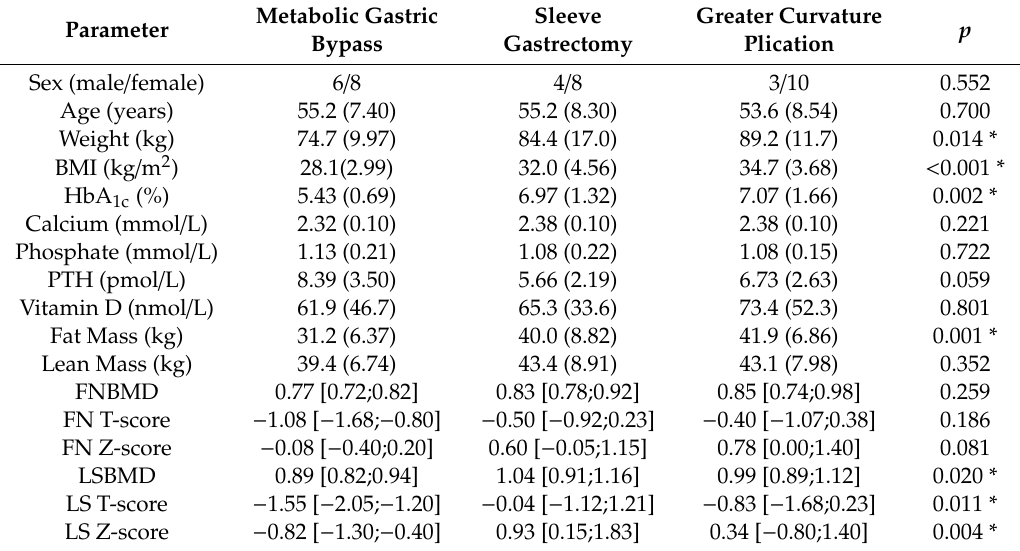
Table 2. Patient’s characteristics 5 years after bariatric